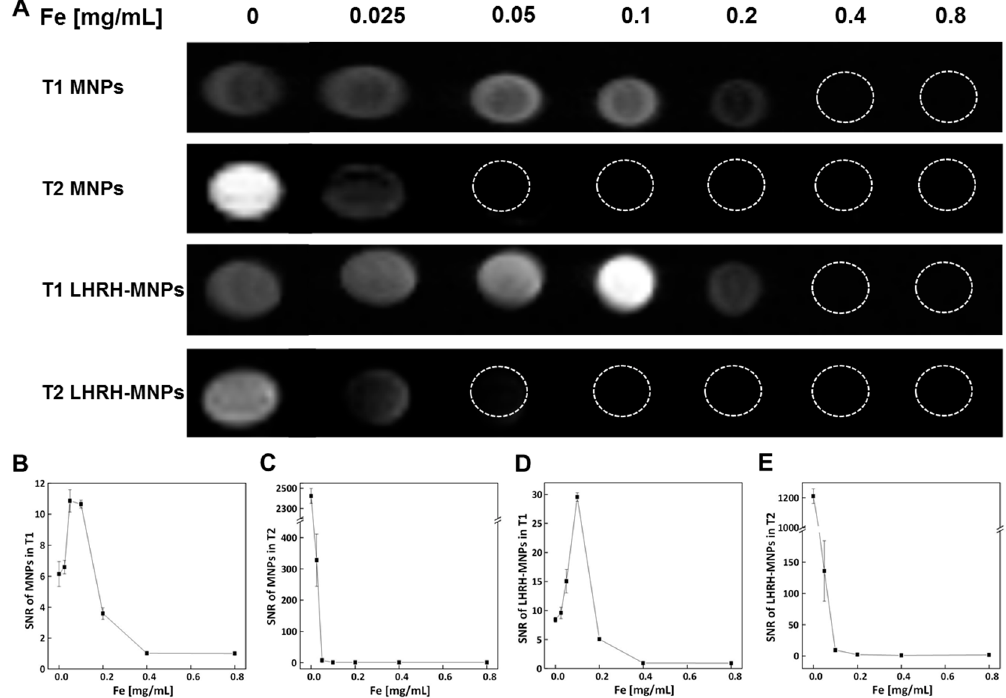
Figure 4. ( A ) In vitro T1- and T2- weighted images of MNPs and LHRH-MNPs in DI water at various iron concentrations. DI water was used as control. Dotted white circles outline the locations of nanoparticle solutions. ( B ) SNR of MNPs in T1-weighted MRI scans. ( C ) SNR of MNPs in T2-weighted MRI scans. ( D ) SNR of LHRH-MNPs in T1-weighted MRI scans. ( E ) SNR of LHRH-MNPs in T2-weighted MRI scans.